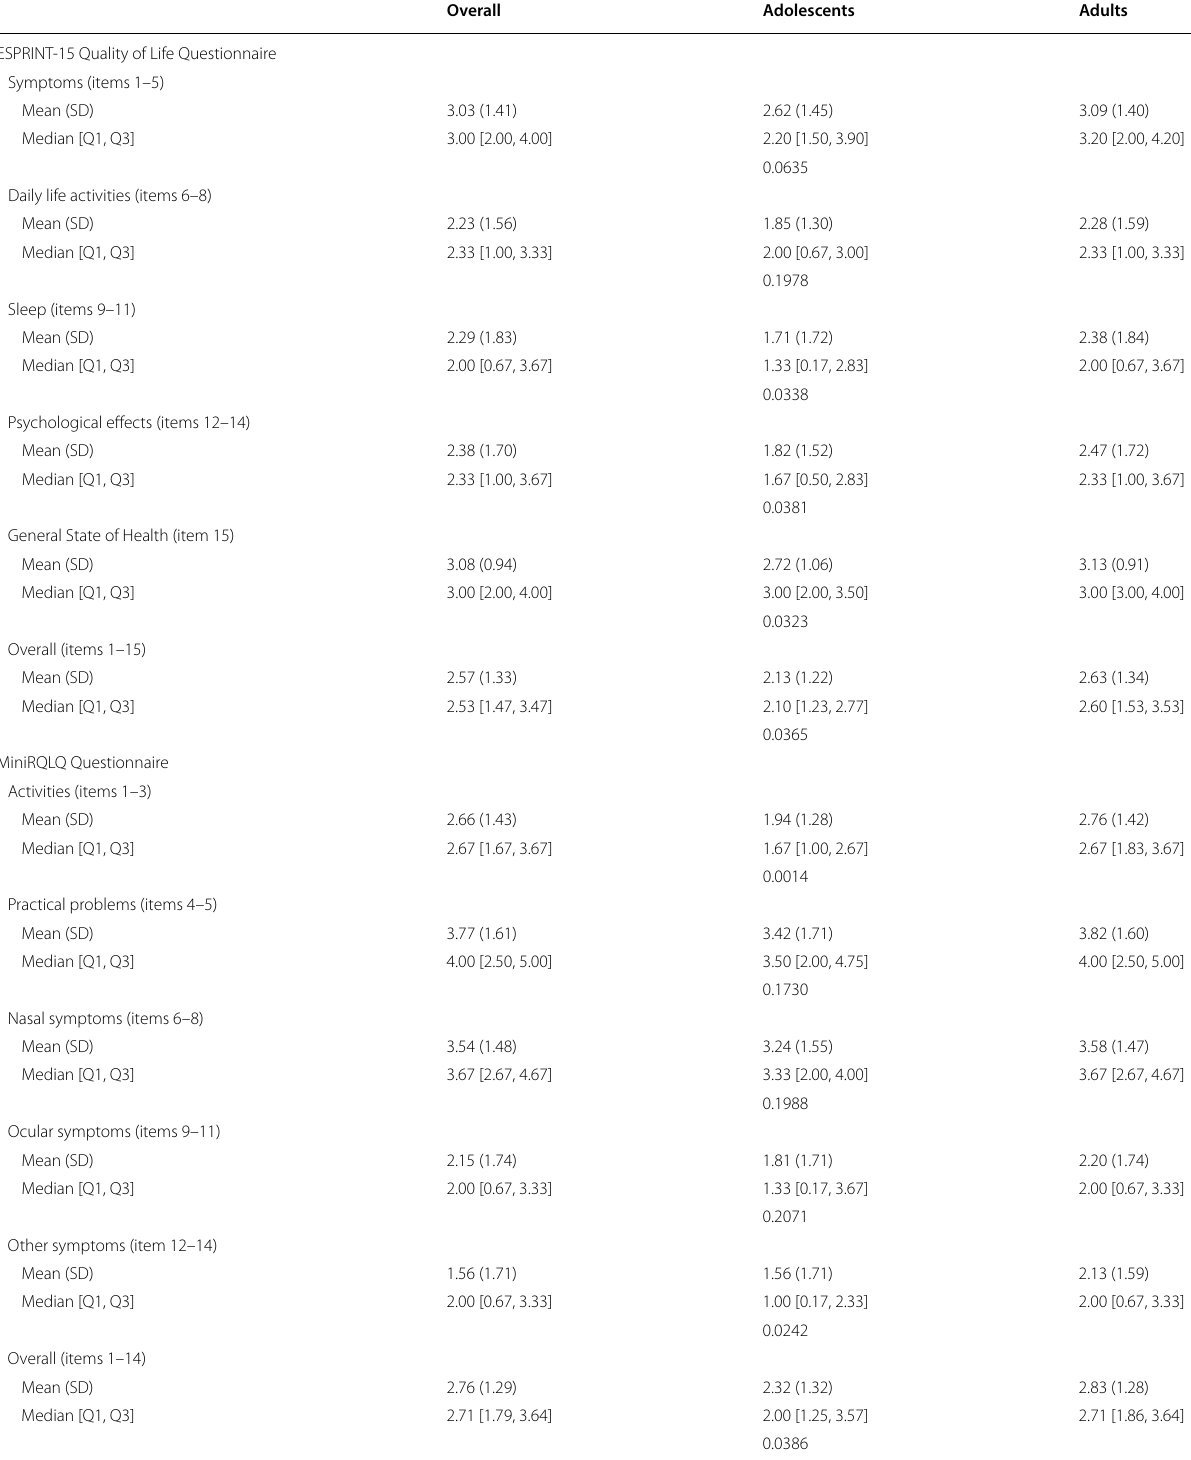
Table 2 Results of the Quality of Life Questionnaires